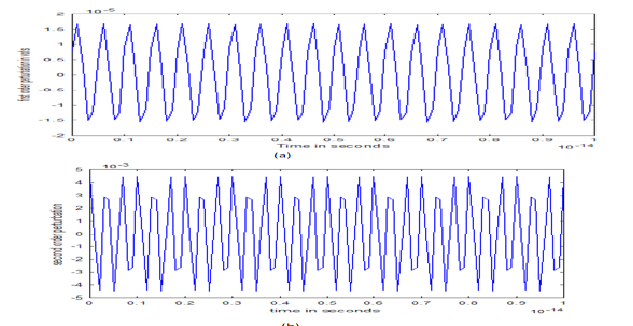
Figure 5: (a) First order perturbation, (b) second order perturbation using Kerr nonlinearity